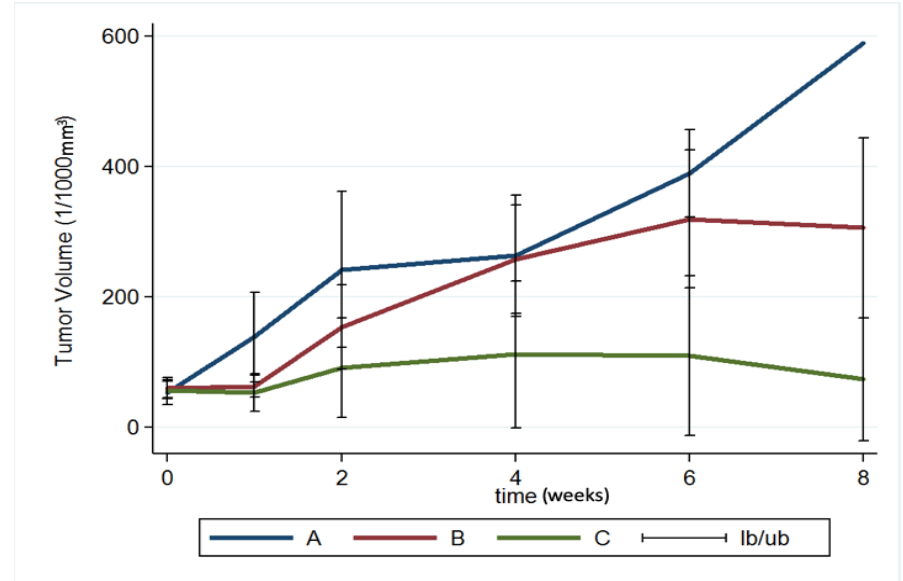
Figure 9. Brain tumor volume. A repeated-measures mixed model was used to evaluate brain tumor volume changes in the three groups. The brain tumor volume in groups A and B increased rapidly and was significantly greater than that in group C (group A vs. group C, p < 0.001; group B vs. group C, p < 0.001) (Ib/ub: inferior bound/ upper bound).